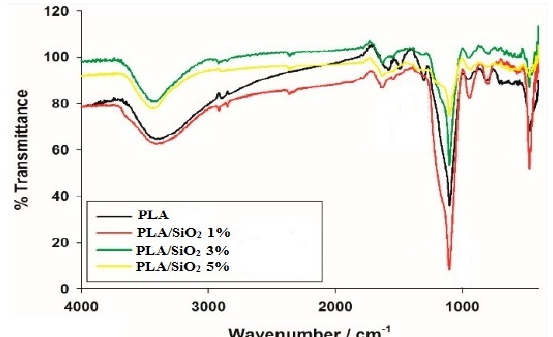
Fig. 5. FTIR spectrum for poly lactic acid film containing silicon Fig 5 . FTIR spectrum for poly lactic acid film containing silicon dioxide nanoparticle dioxide